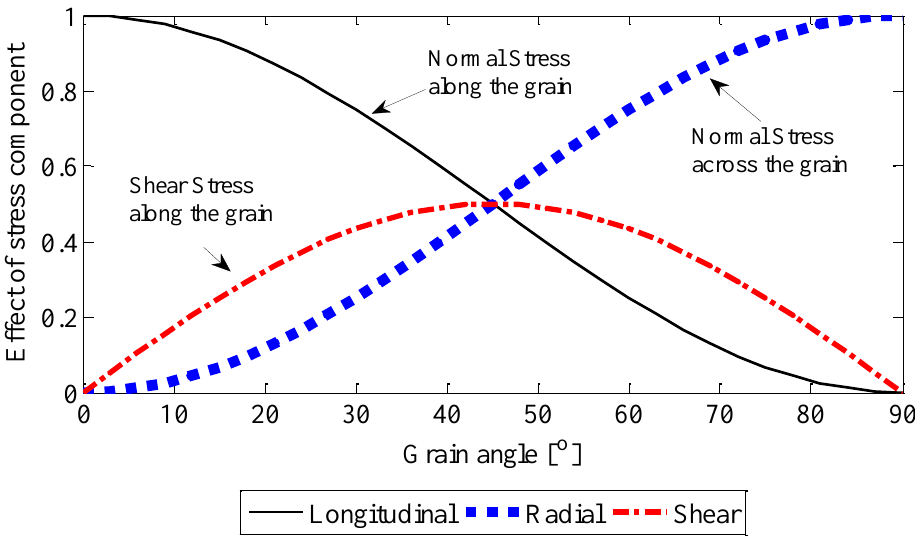
Figure 9. The effect of stress component ( σ ij / σ f ) versus grain angle. σ ij ( i , j = L , R ) is the stress component, and σ f is the stress in the load direction at a tensile loading of 1 kN; symbols L and R represent the principal anatomical directions: i.e., longitudinal direction and radial direction.